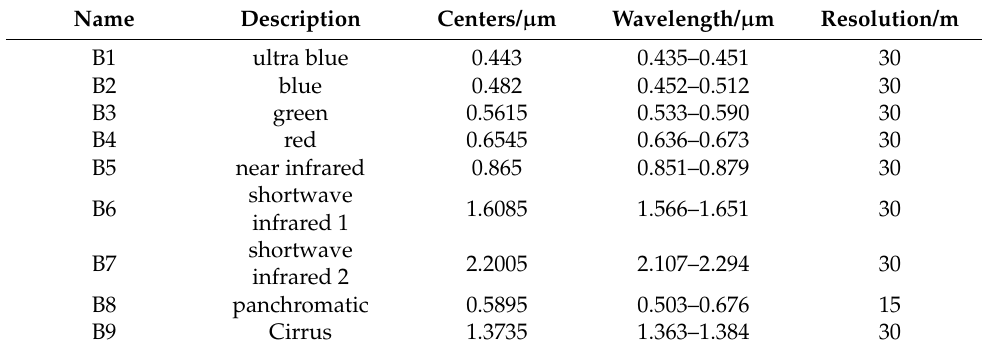
Table 2. Spectral band details for Landsat 8 OLI sensor.